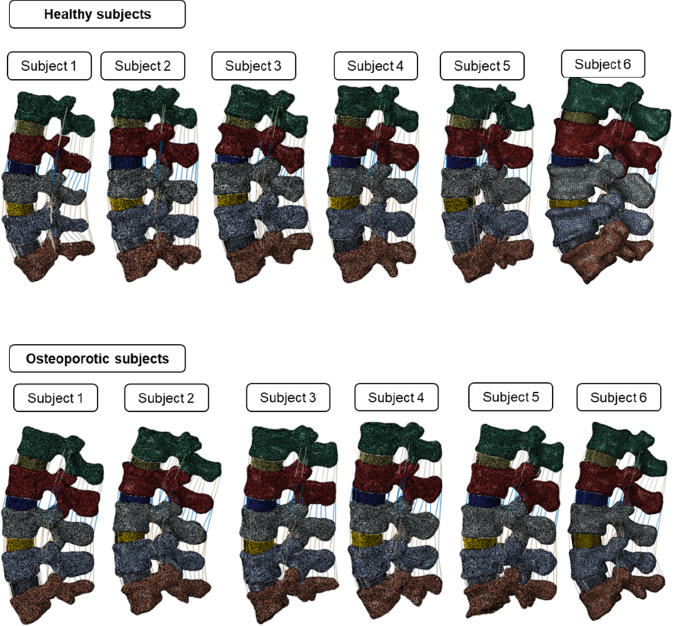
Figure 3. The meshed comprehensive lumbar spine geometries used in the current study. The top row shows the healthy subjects; the bottom row shows the osteoporotic subjects. For replicating the realistic mechanical behavior of the model under the applied load- ing condition, a tie constraint was given between nucleus and annulus of IVDs, nucleus and vertebrae, annulus and vertebrae, and ligaments and vertebrae [45]. The inferior sur- face of the lumbar spine was fixed in all six directions. For calculation of the FL, normal displacement load was applied on the superior surface, the model was simulated, and the variation of load and displacement was captured. The peak of the load-displacement curve was considered the FL. This methodology was validated with experimental studies in previous work [15,20]. For studying the kinematics, we applied a pure moment of 7.5 Nm on the superior surface of the lumbar spine and simulated flexion, extension, lateral bending, and twisting motions [46]. In addition, we have plotted the variation of ROM with angular displacement. This methodology was validated in the previous works [21,42]. The applied loading and boundary conditions and the final deformed contour af- ter the simulation are shown in Figure 4.